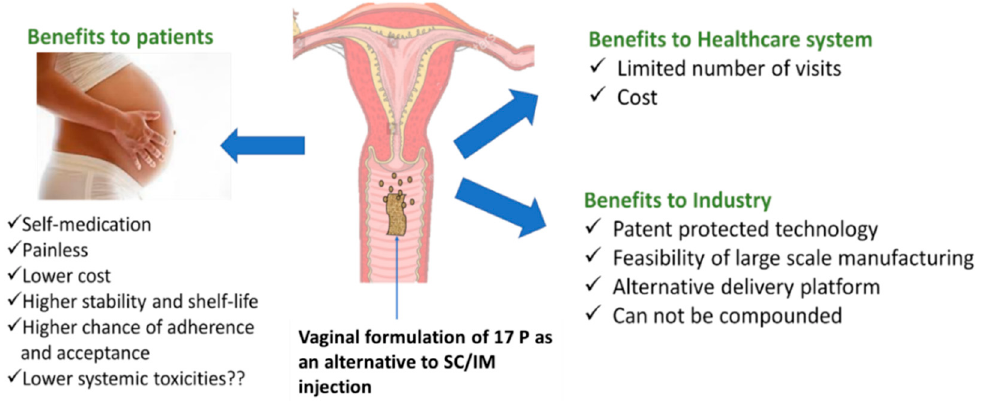
Figure 7. Schematic describing advantages of vaginal delivery of 17P.